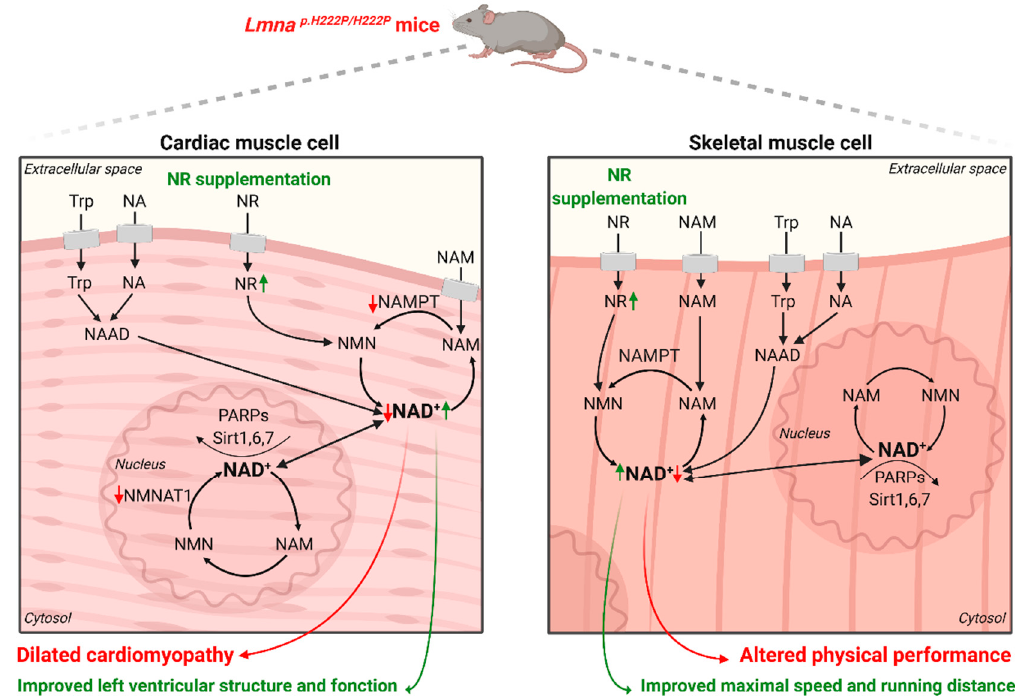
Figure 4. Main reported alterations in the NAD + metabolism in a mouse model of striated muscle laminopathy: in cardiac tissue of Lmna p.H222P / H222P mice, an altered NAD + salvage pathway